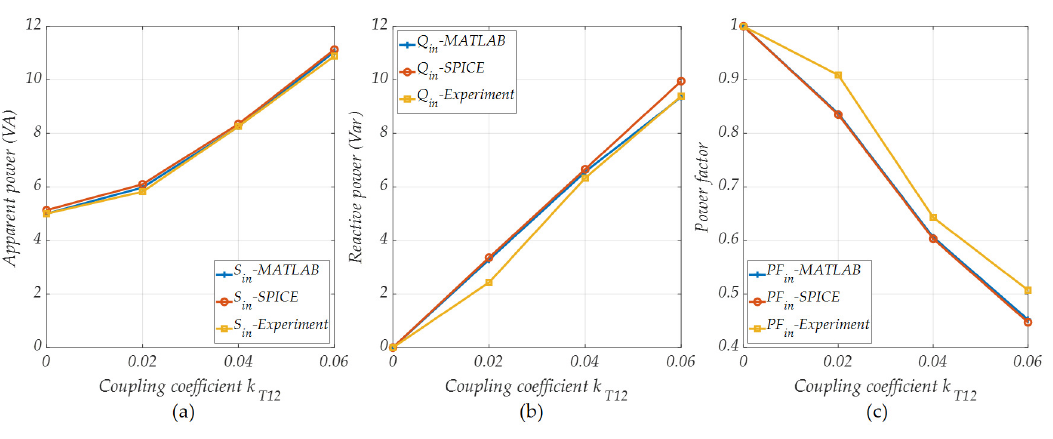
# » V bf : ( a ) S in , ( b ) Q in , and ( c ) PF in . T